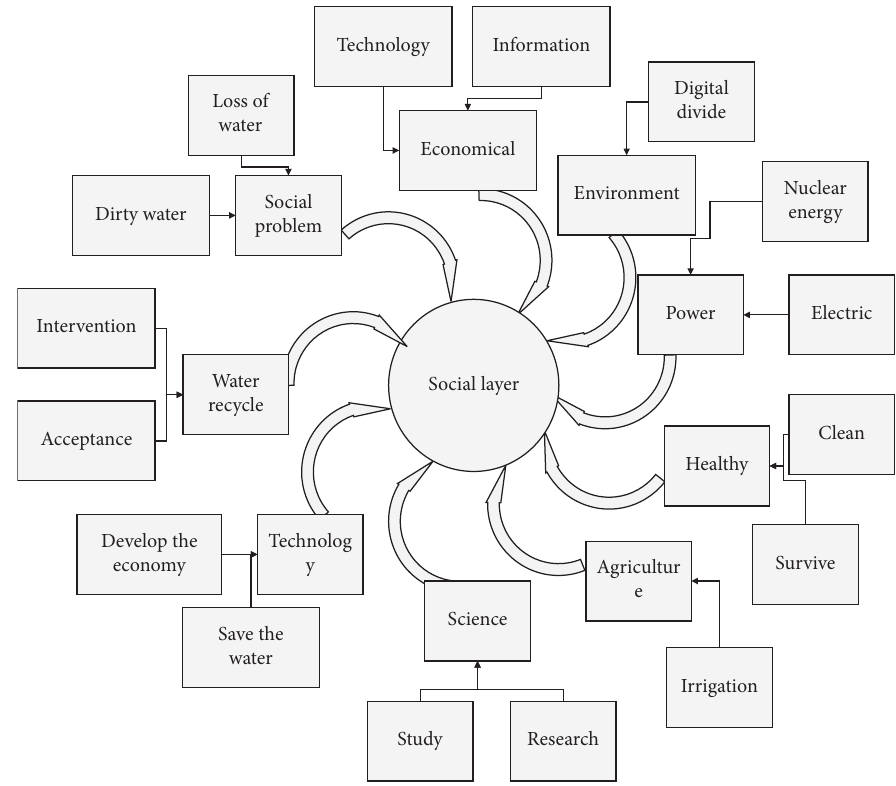
Figure 2: Water resources-ecology-economy-socioeconomic systems.